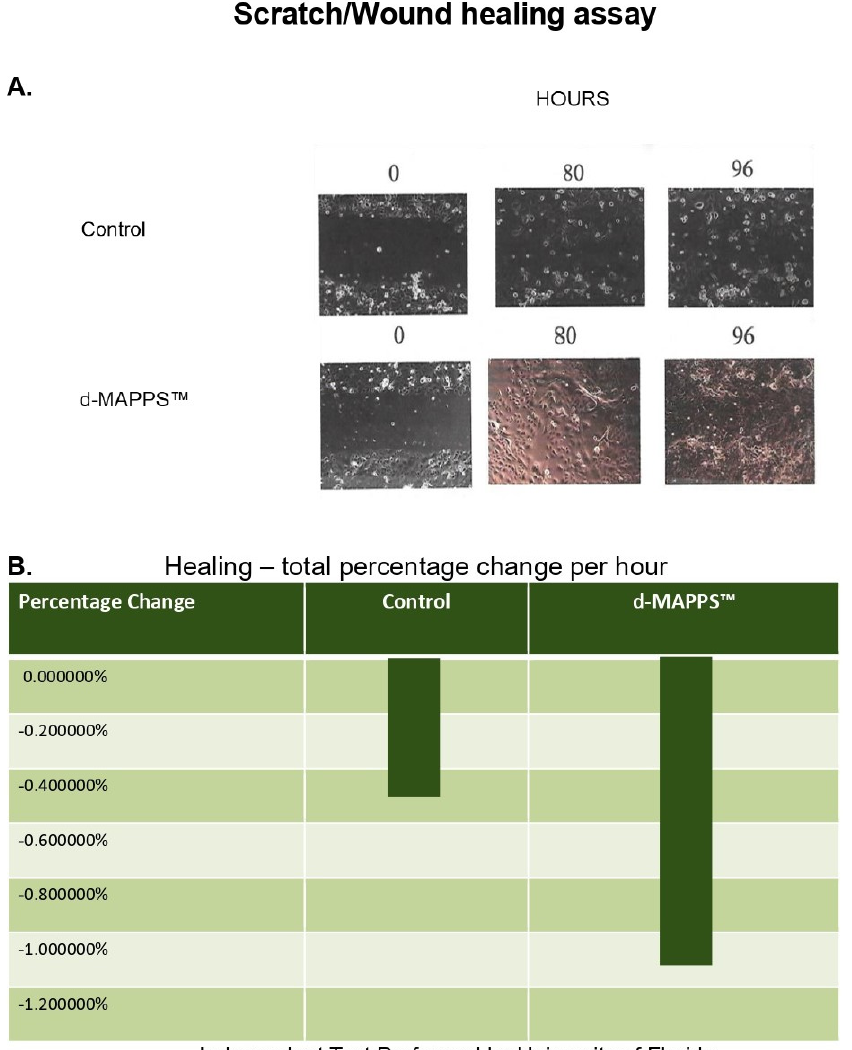
Figure 1. Therapeutic potential of d-MAPPS™ in the treatment of corneal wounds. ( A ) Cell-to-cell contact of the human corneal epithelial cell was completely restored after 96 h of d-MAPPS™-based treatment. ( B ) Scratch/wound healing assay showed that d-MAPPS™ significantly improved the proliferative and migratory properties of human corneal epithelial cells in vitro, indicating the therapeutic potential of d-MAPPS™ in the treatment of corneal